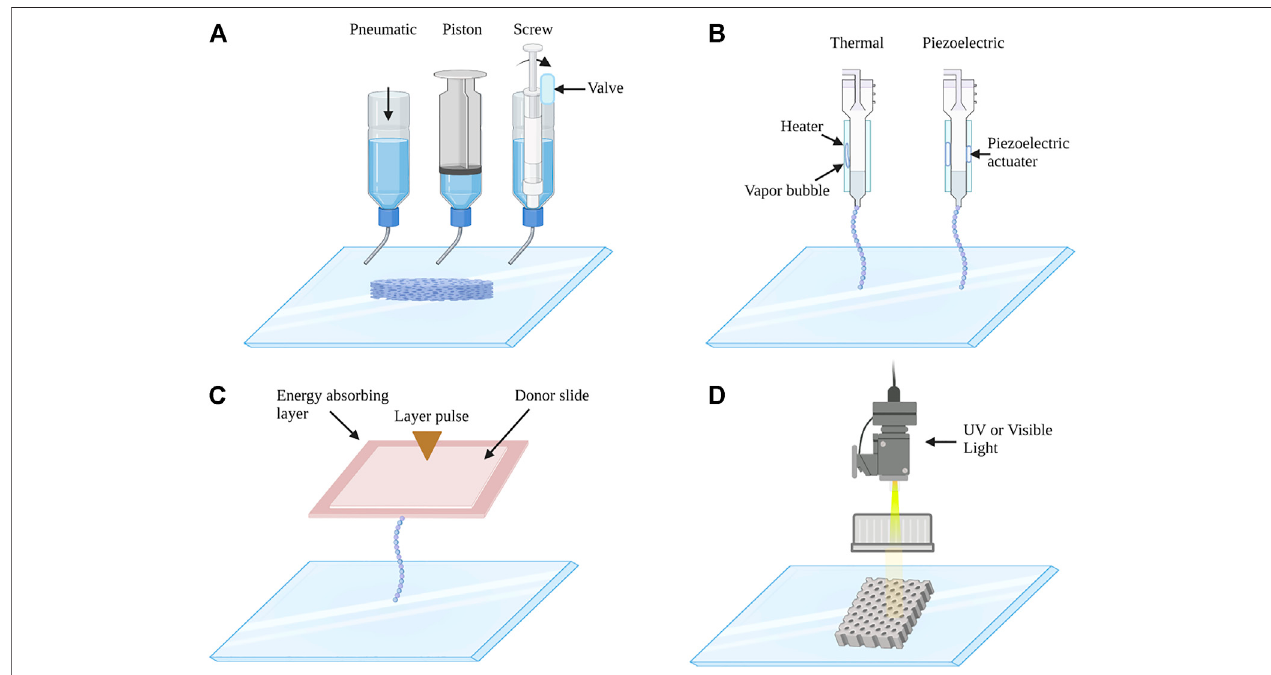
FIGURE 2 | Schematic images of (A) extrusion-based, (B) inkjet-based, (C) laser-assisted, and (D) stereolithography 3D bioprinting system. (A) Extrusion-based 3D bioprinting: extrusion bioprinters use pneumatics, piston, or screw force to continuously extrude a liquid cell-hydrogel solution. (B) Inkjet-based 3D bioprinting: the printer heads are deformed by a thermal or piezoelectric actuator and squeezed to generate droplets of a controllable size. (C) Laser-assisted 3D bioprinting: laser bioprintersusealasertovaporizearegioninthedonorlayer(top)formingabubblethatpropelsasuspendedbioinktofallontothesubstrate. (D) Stereolithography 3D bioprinting: stereolithographic printers use a digital UV or visible light projector to selectively cross-link bioinks